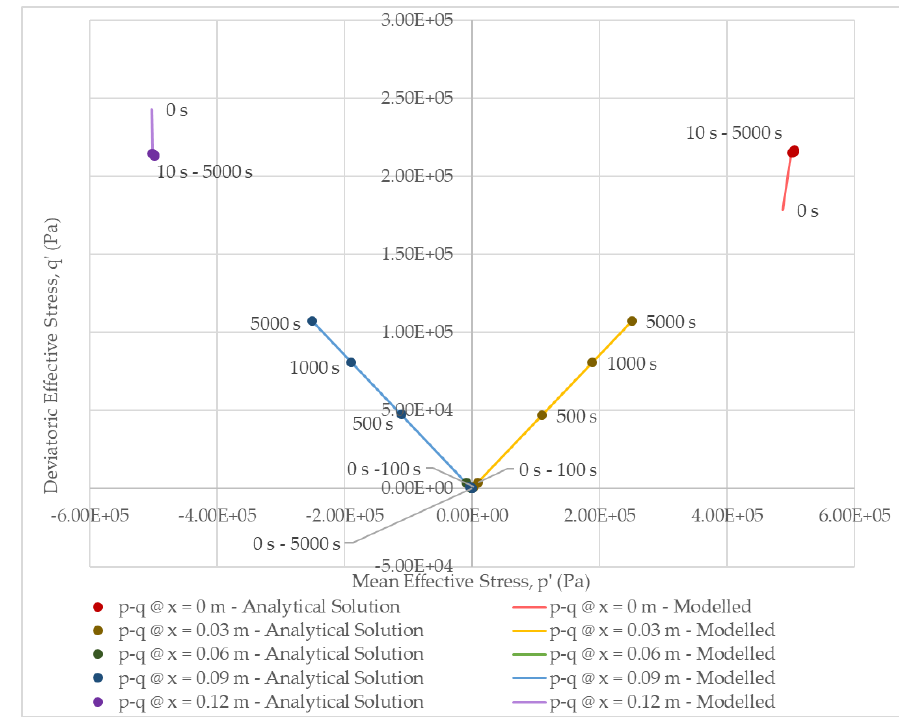
Figure 11. Verification study—1D transient solution results showing the p-q stress paths along the length of the soil specimen.